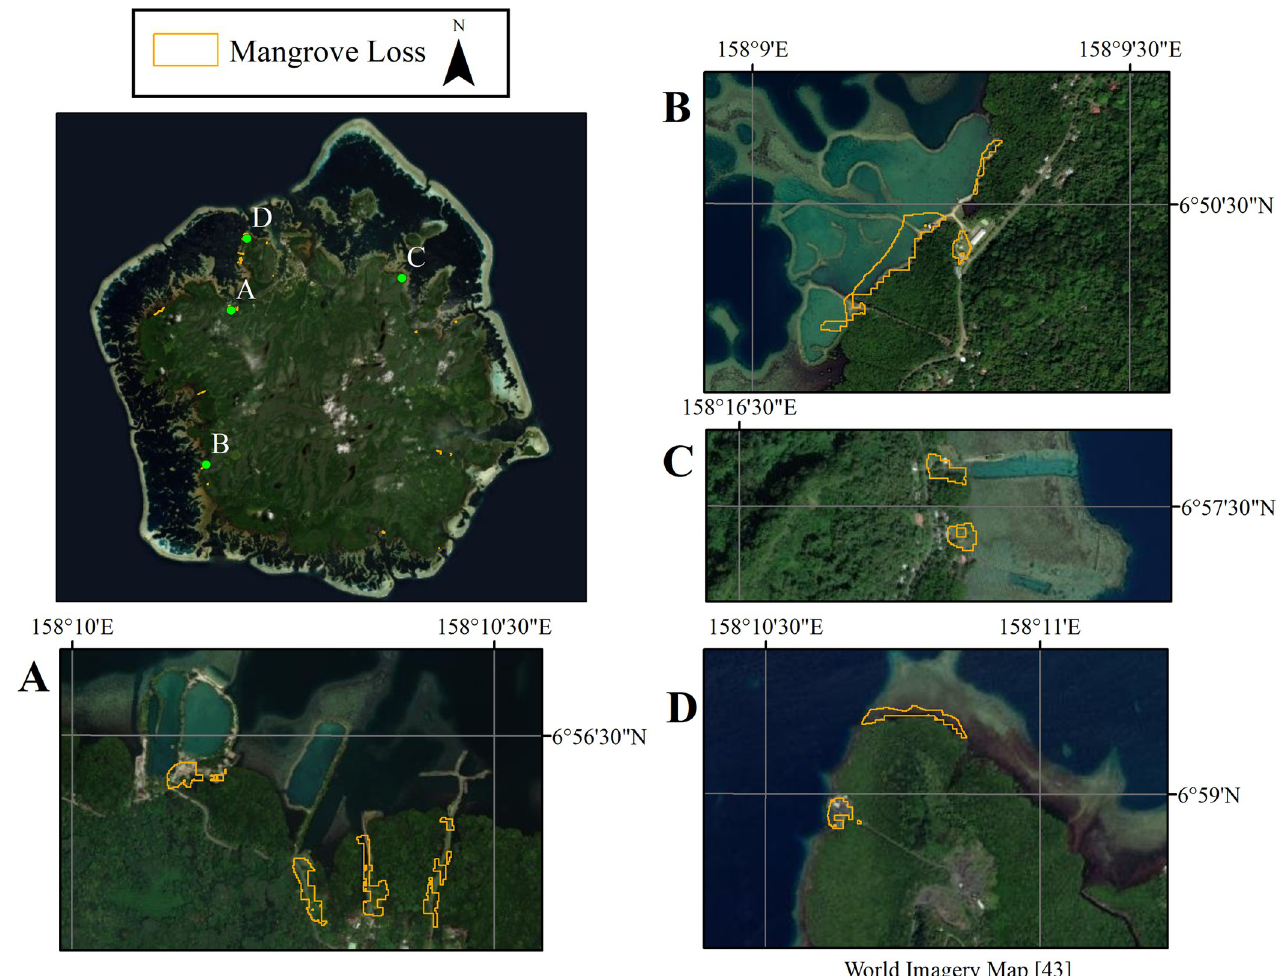
Fig 2. Mangrove loss. Areas of mangrove loss between 1983 and 2018 were primarily due to direct human activity such as building of roads, channels, commercial and residential areas, and industrial ponds (examples can be seen in images A-C). Other mangrove loss could be due to erosion (image D). Note images A-D correspond to green points in top left image. Satellite imagery seen in the figure is an Esri’s ArcGIS basemap [43]. https://doi.org/10.1371/journal.pone.0271589.g002 PLOS ONE | https://doi.org/10.1371/journal.pone.0271589 July 21,